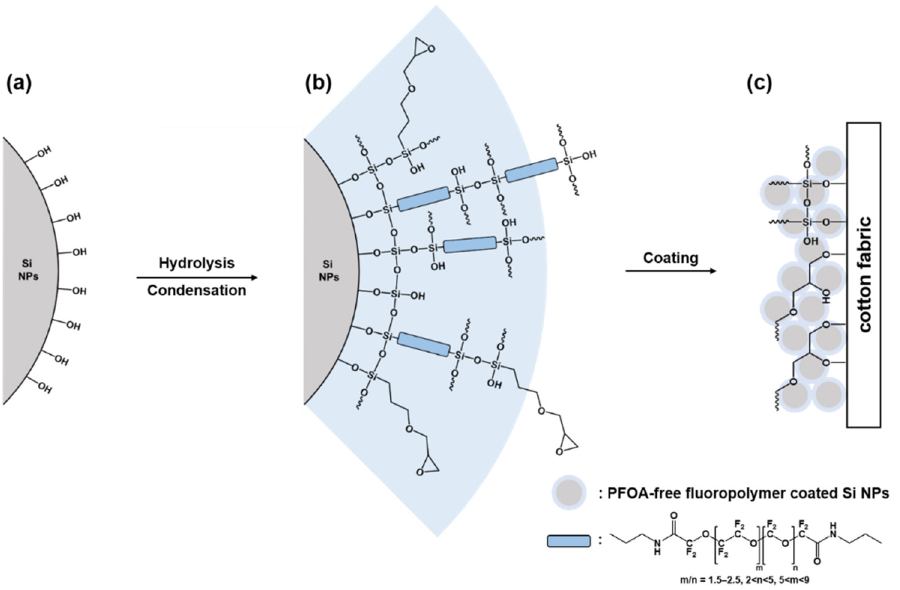
Figure 1. Schematic representation of OmniBlock coating onto cotton fabric ( a ) Si NPs from TEOS, ( b ) PFOA-free fluoropolymer-coated Si NPs (OmniBlock), and ( c ) dip–dry–cure results.